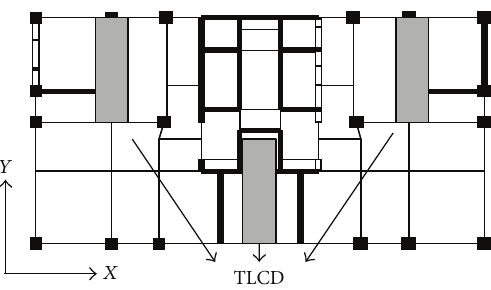
Figure 5: Deployment of three TLCDs on the top